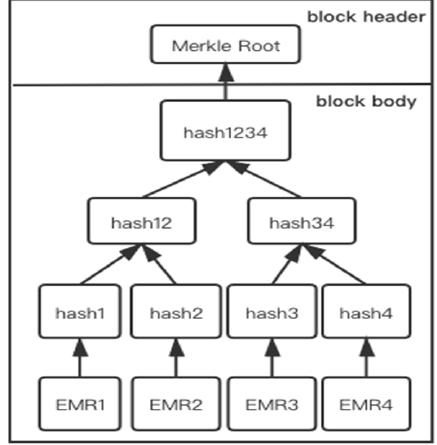
Figure 11. Block structure and Merkle tree in the proposed scheme.